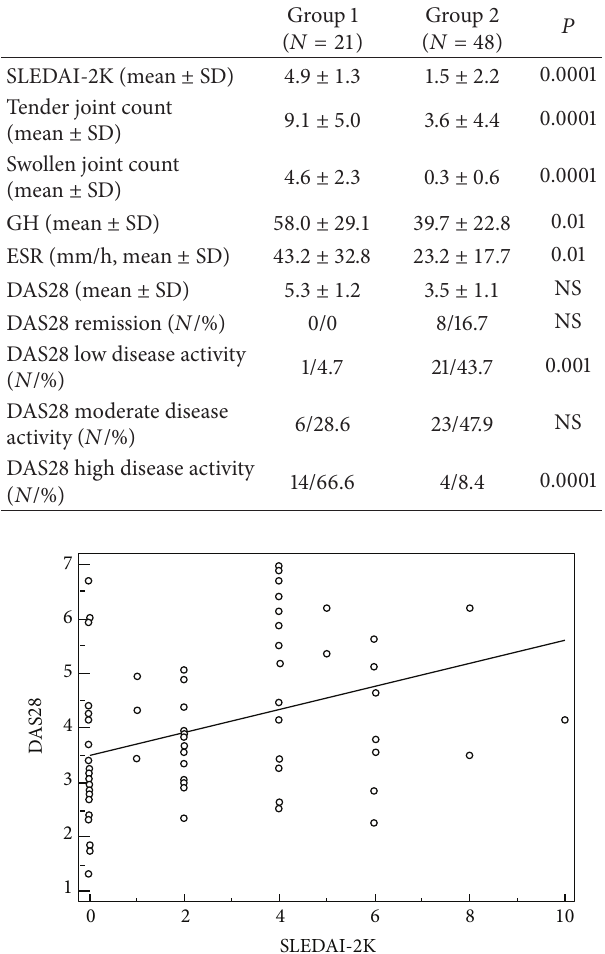
Table 2: Comparison of disease activity parameters and status according to SLEDAI-2K definition of articular involvement (Group 1—patients with joint involvement defined by SLEDAI-2K, Group 2—patients without joint involvement defined by SLEDAI-2K).